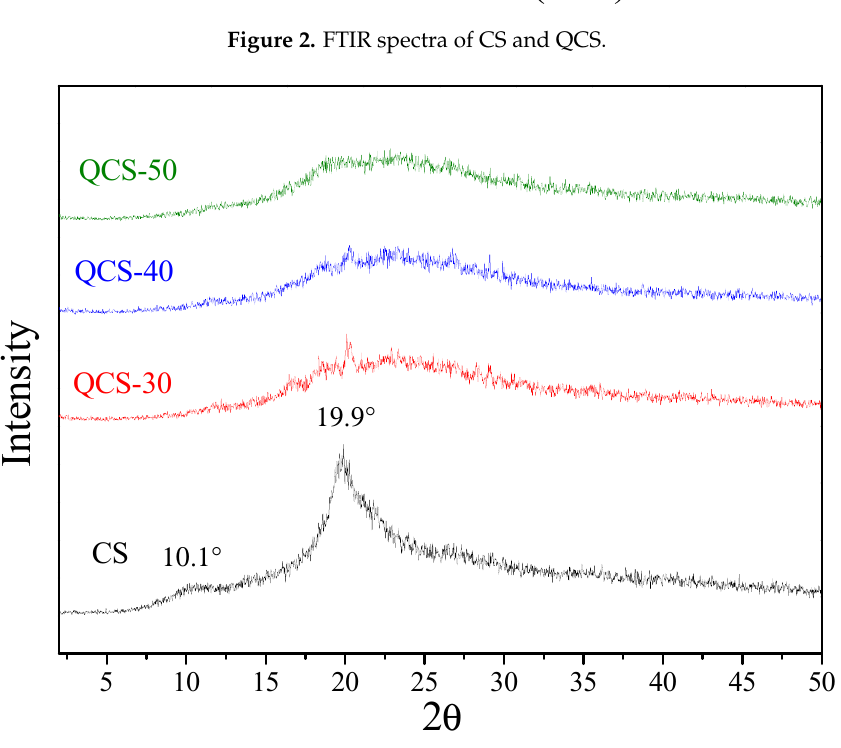
Figure 3. WAXD spectra of CS and QCS.